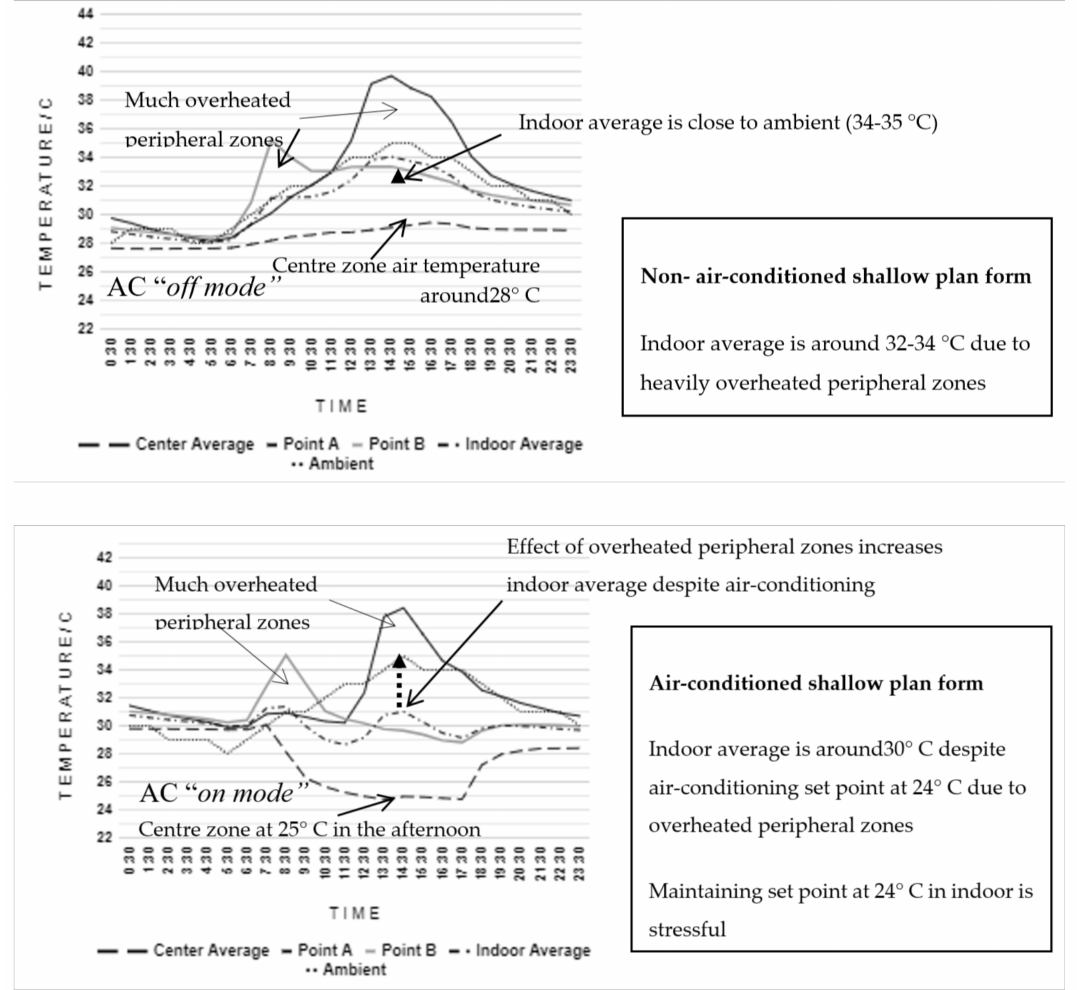
Figure 4. Air temperature inside 5th floor of Building A with shallow plan, Top—AC o ff -mode and Bottom—AC on-mode, overheated indoors due to environmental heat gain in both